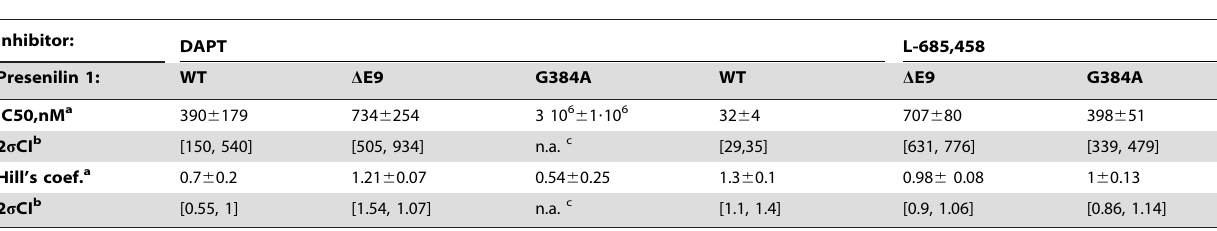
Table 3. Inhibition of WT presenilin 1 and FAD mutants by (Fig. 9) a.